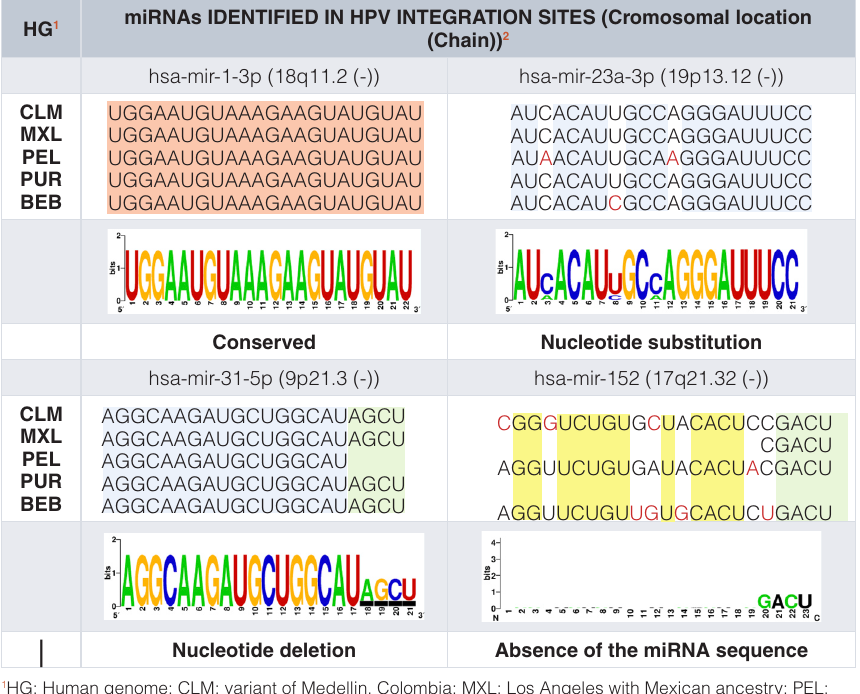
Table 7. miRNAs identified in HPV integration sites, displaying the nucleotide variations in the selected Latin American human genome variants and the control variant. More data is available in Supplementary File